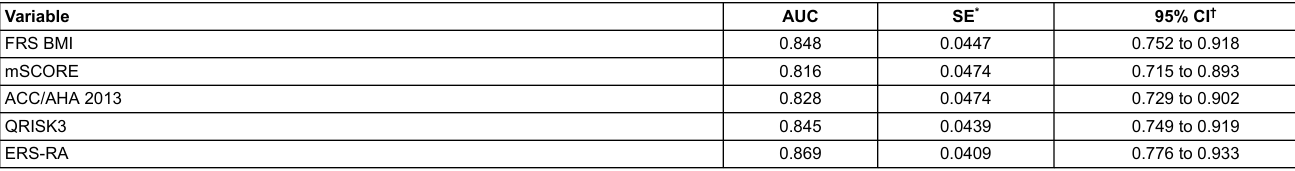
Table 3: Area under the receiver operating characteristic curves (standard error and 95% confidence intervals) to distinguish patients in regard to presence of subclinical athero- sclerosis as defined by the presence of carotid intima-media thickness over 0,9 mm and/or carotid plaques (US+). Variable